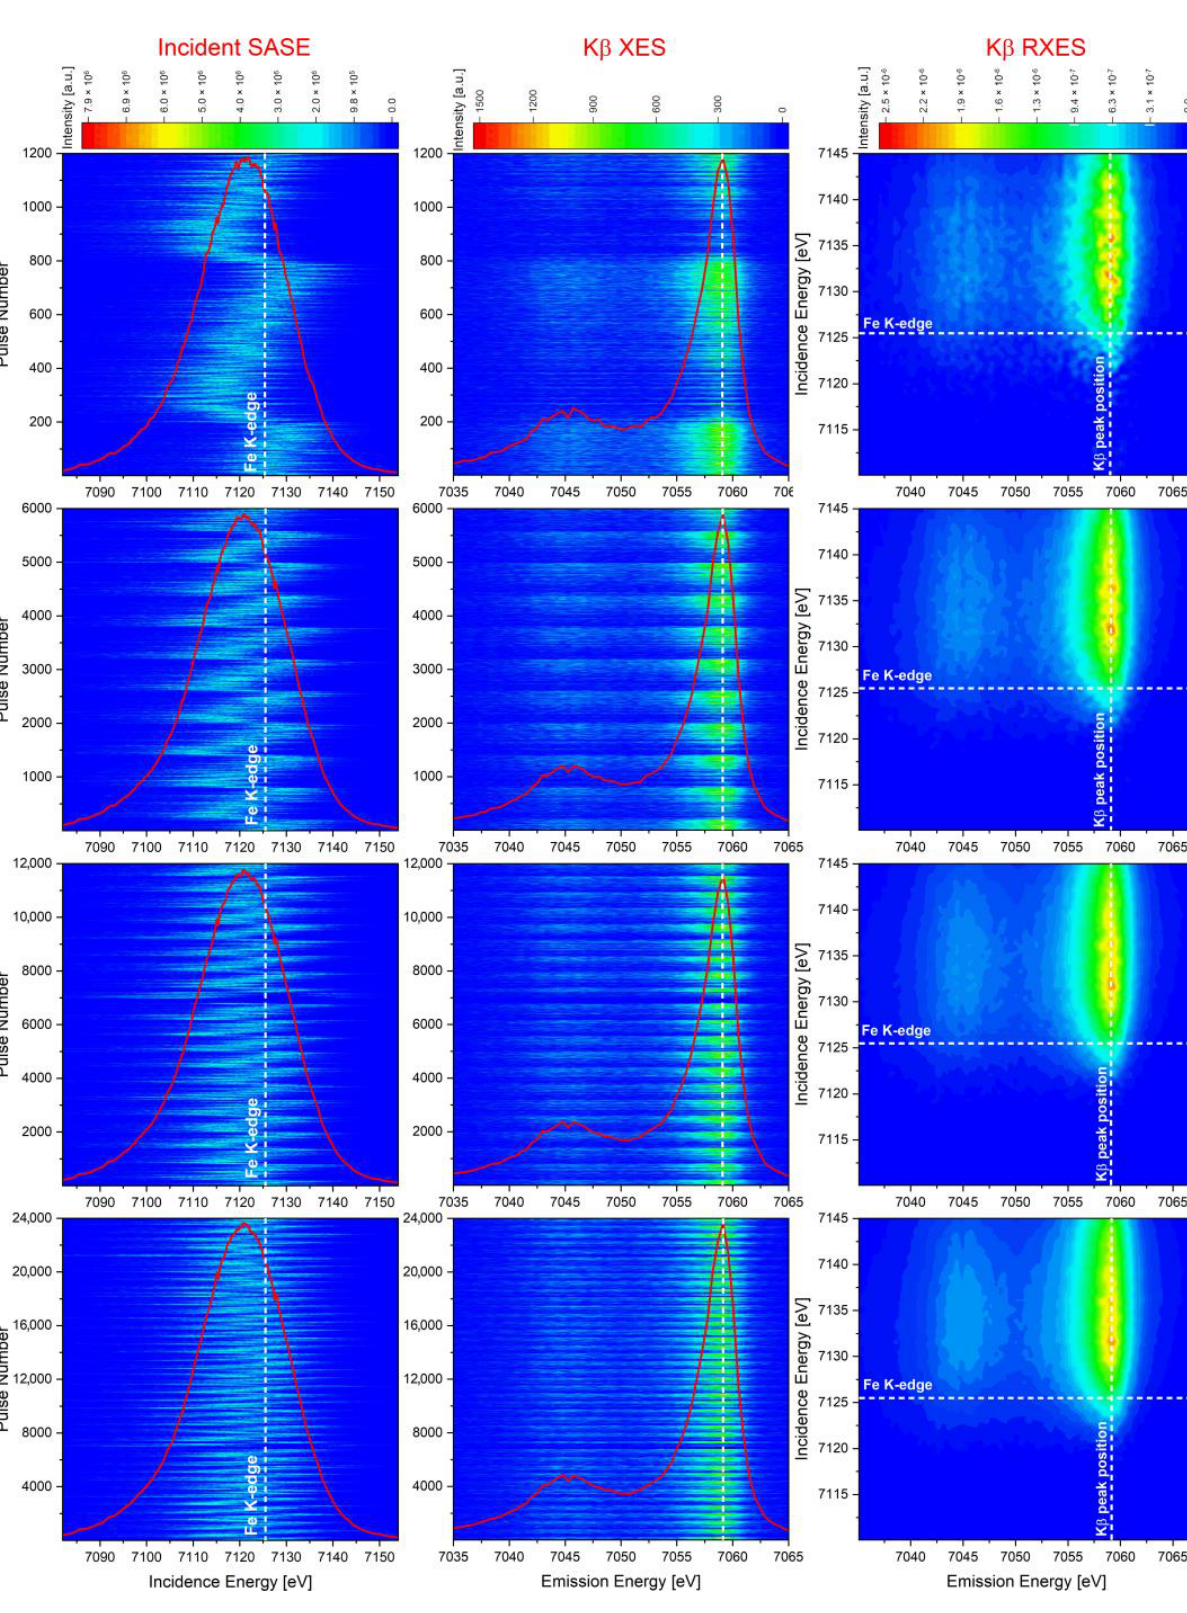
Figure 1. The measured incident SASE and Fe Kβ XES spectra (left and central column) and the Fe Kβ RXES planes (right column) reconstructed for: 1200, 6000, 12,000, and 24,000 pulses (rows 1 – 4).